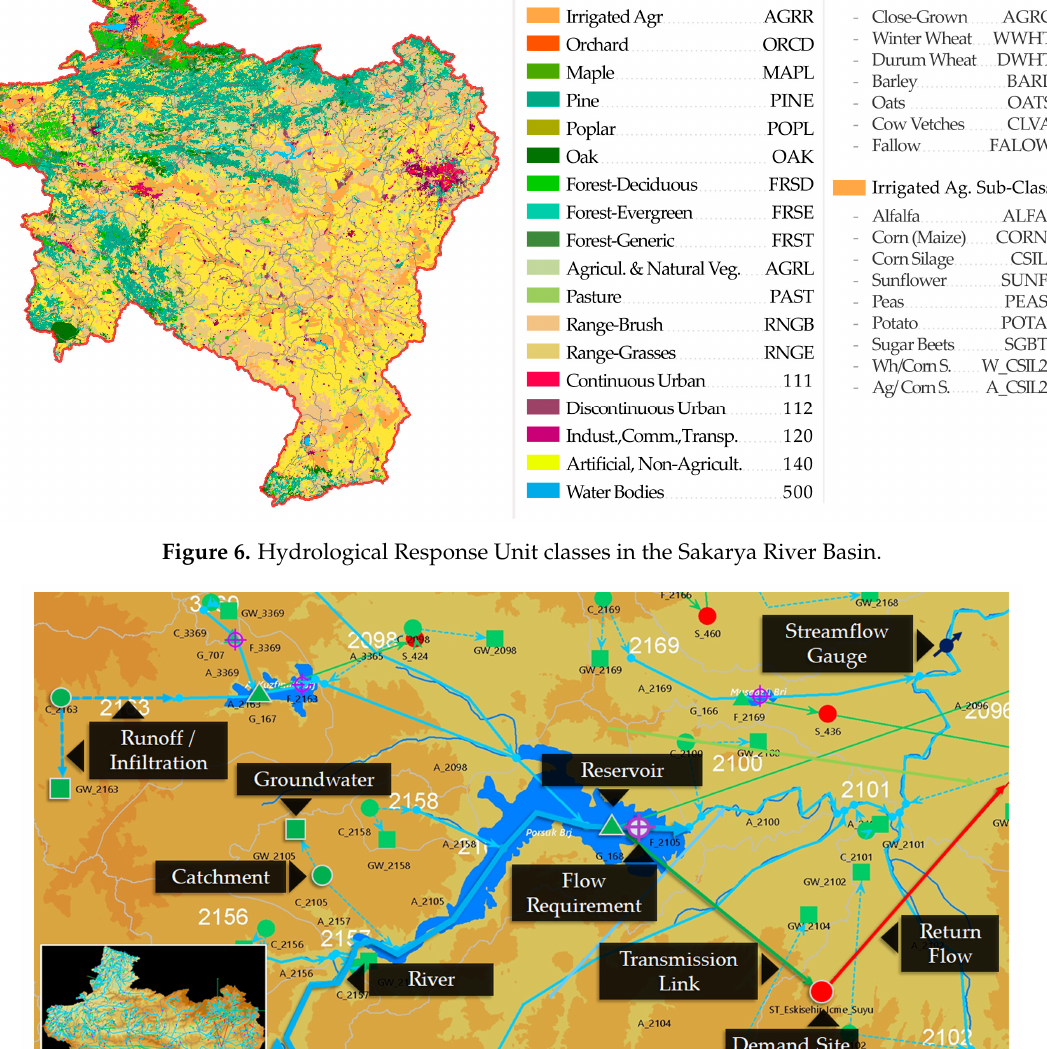
Figure 7. Representation of the Sakarya River Basin’s WEAP-PGM modules.